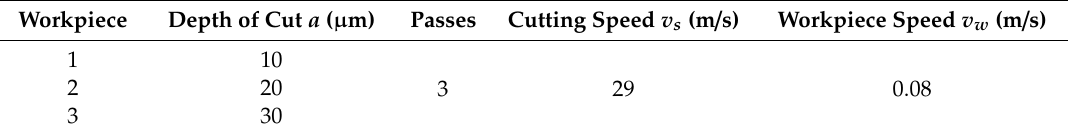
Table 1. Grinding test